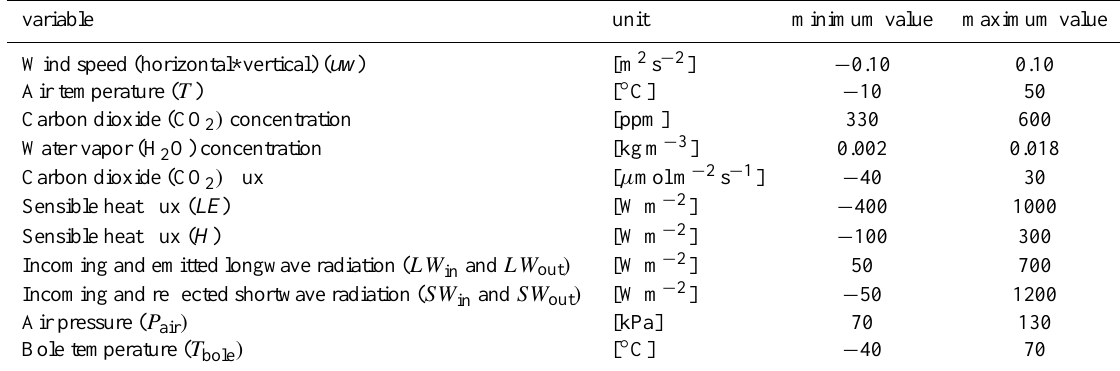
Table 3. Ranges of values used in the quality check of the meteorological data. variable unit minimum value maximum value Wind speed (horizontal*vertical) ( uw